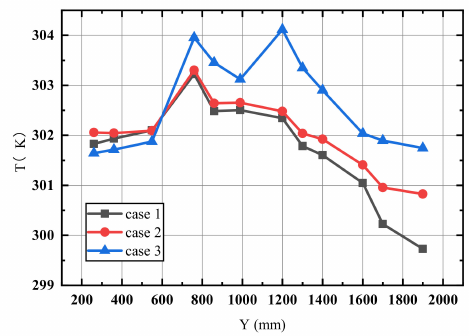
Figure 12. Comparison of ambient temperature in rack. Case 1: new type of air cooling; Case 2: traditional air cooling of 120 ◦ lower air supply; Case 3: traditional air cooling of 45 ◦ upper air